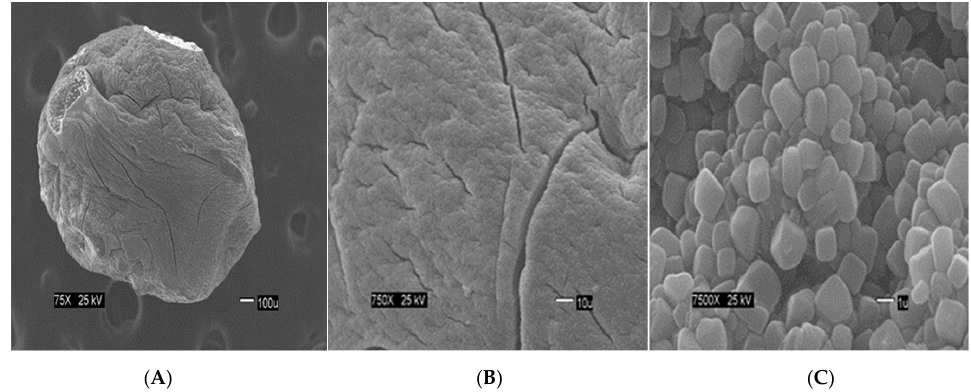
Figure 3. SEM images at three different magnitudes of CA beads: ( A ): 75×; ( B ): 750× and ( C ): 7500×.